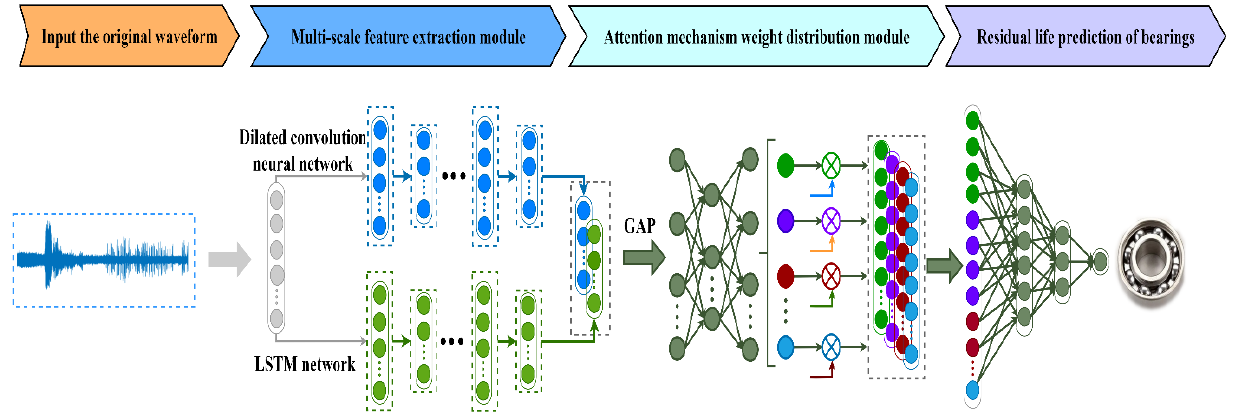
Figure 4. Network model of rolling bearing remaining life prediction method based on multi-scale feature extraction and attention mechanism.